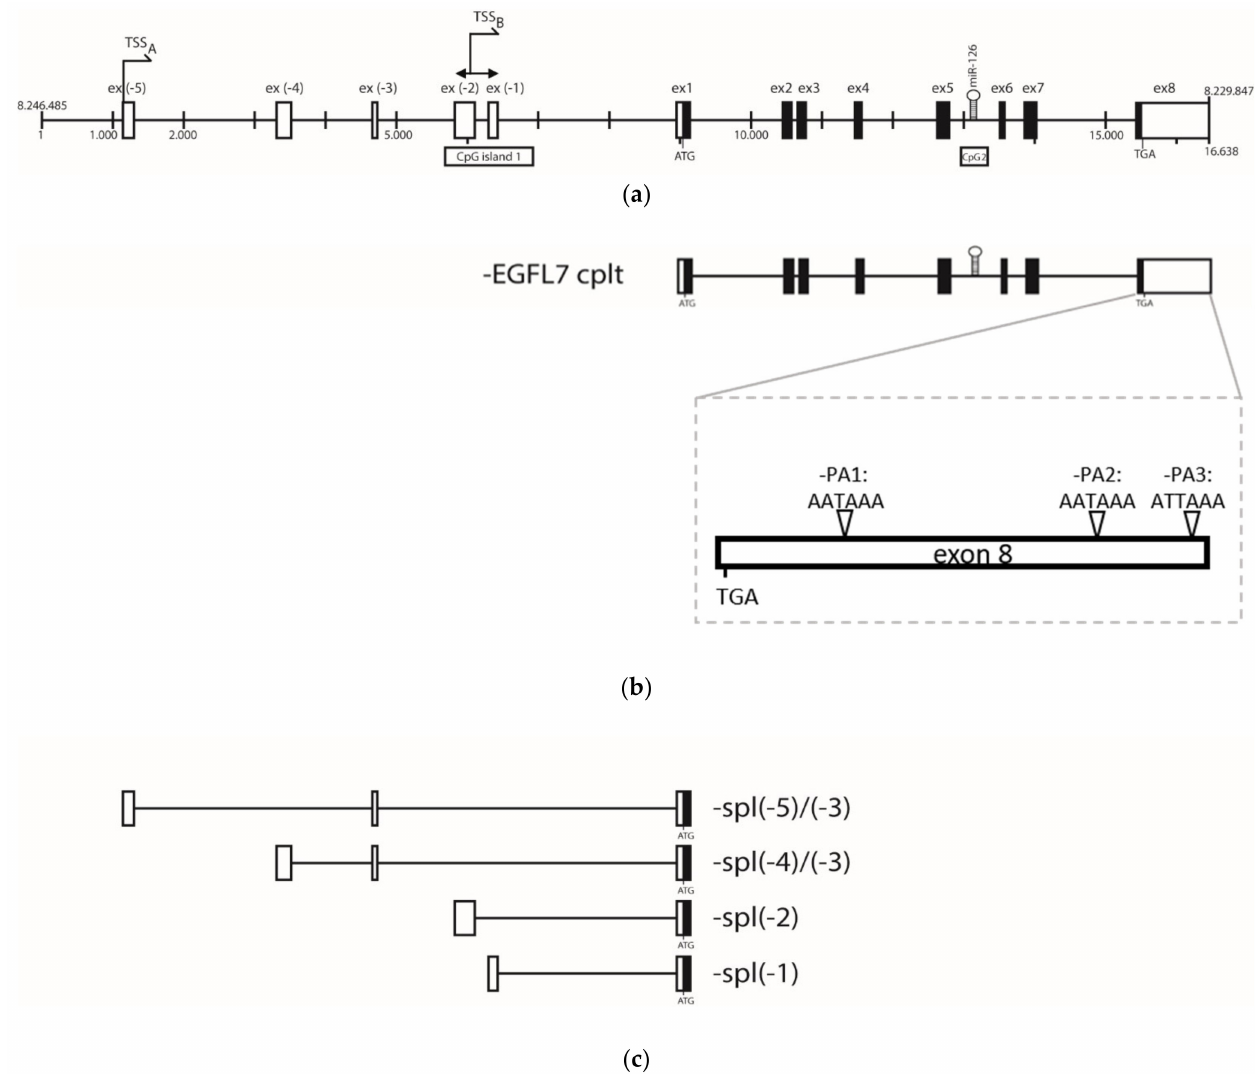
Figure 2. Schematic representation of the epidermal growth factor like-7 ( EGFL-7 ) gene and alternative transcripts. ( a ) The full-length EGFL-7 gene with two major transcriptional start sites (TSSs) and CpG islands. Gene structure and exon annotations were established from bioinformatics predictions available for EGFL-7 . ( b ) An alternative transcript including exons 1 to 8 and a detail of exon 8 showing the different functional polyadenylation signals (PA) sites (PA1, PA2, and PA3). TGA is the codon stop. Primers used to perform the 3 (cid:48) RACE are listed in Table A1. ( c ) Four alternative transcripts from exon − 5 to exon 1. All alternative transcripts are available in Figure S1. Non-coding exons are represented by white boxes. Coding exons are represented by black boxes. The black bars are introns. MiR-126 is represented by a stem-loop structure in the fifth